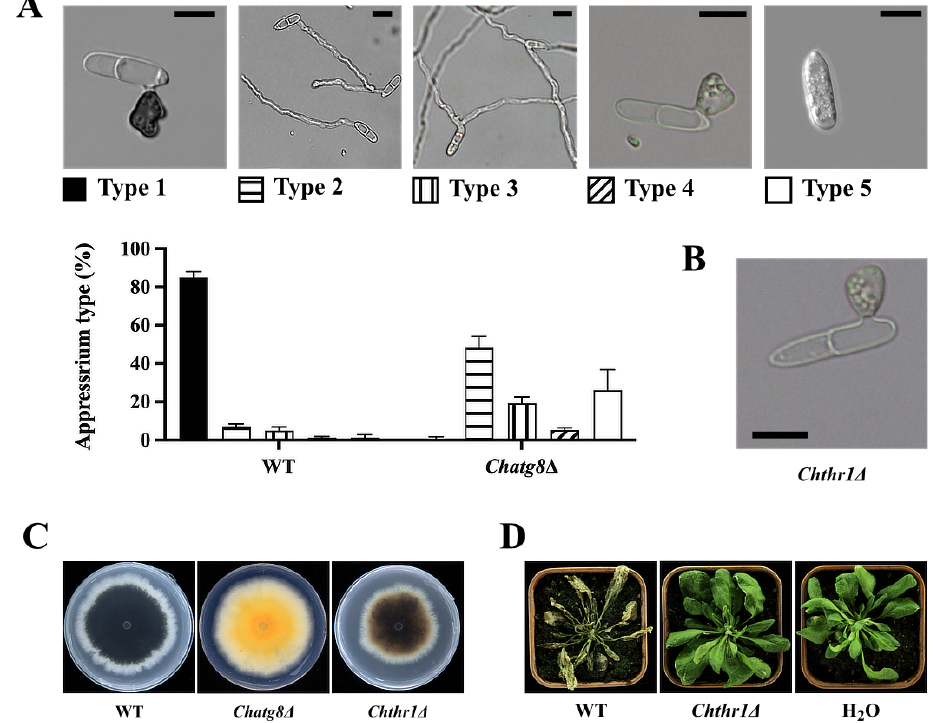
Figure 7. Loss of ChATG8 or ChTHR1 gene resulted in reduced appressoria and colony melanin and loss of pathogenicity. ( A ) Micrographs show different types of appressorial development in WT and Chatg8 Δ strains on hydrophobic coverslips at 24 hpi at 27 °C in distilled water. The percentage of different types of appressorial development at 24 hpi was recorded from a sample of 100 conidia. The bar charts show the mean and standard deviation from three independent replications of the experiment. Black scale bar = 10 μm. ( B ) Micrographs show different types of appressorial devel- opment in Chthr1 Δ strains on hydrophobic coverslips at 24 hpi at 27 °C in distilled water. Black scale bar = 10 μm. ( C ) Colony morphology of the WT, Chatg8 Δ, and Chthr1 Δ strains grown on PDA medium for 7 d. ( D ) Arabidopsis plants were inoculated by spraying conidial suspensions of indicated strains or sterilized water (H 2 O). Inoculated plants were photographed at 5 d post inocula- tion.